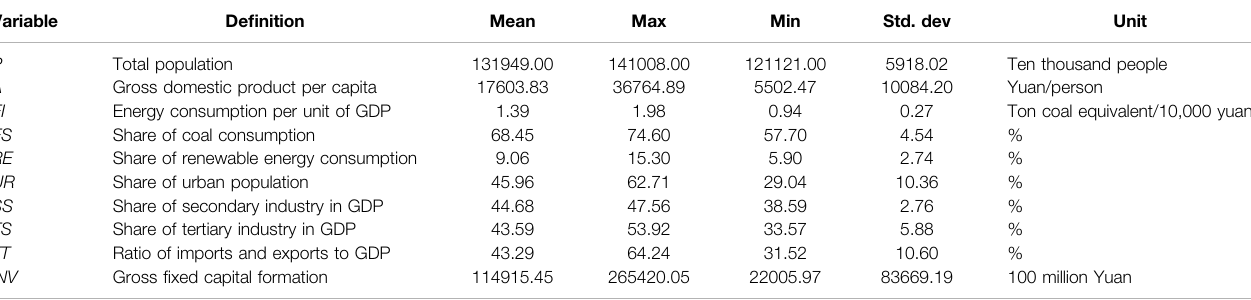
TABLE 2 | Statistical description of variables.